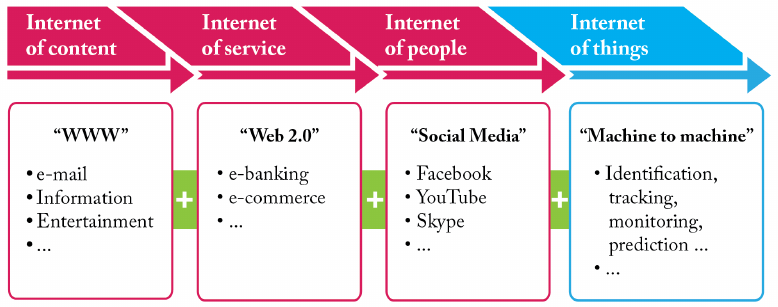
Figure 1. The evolution of the